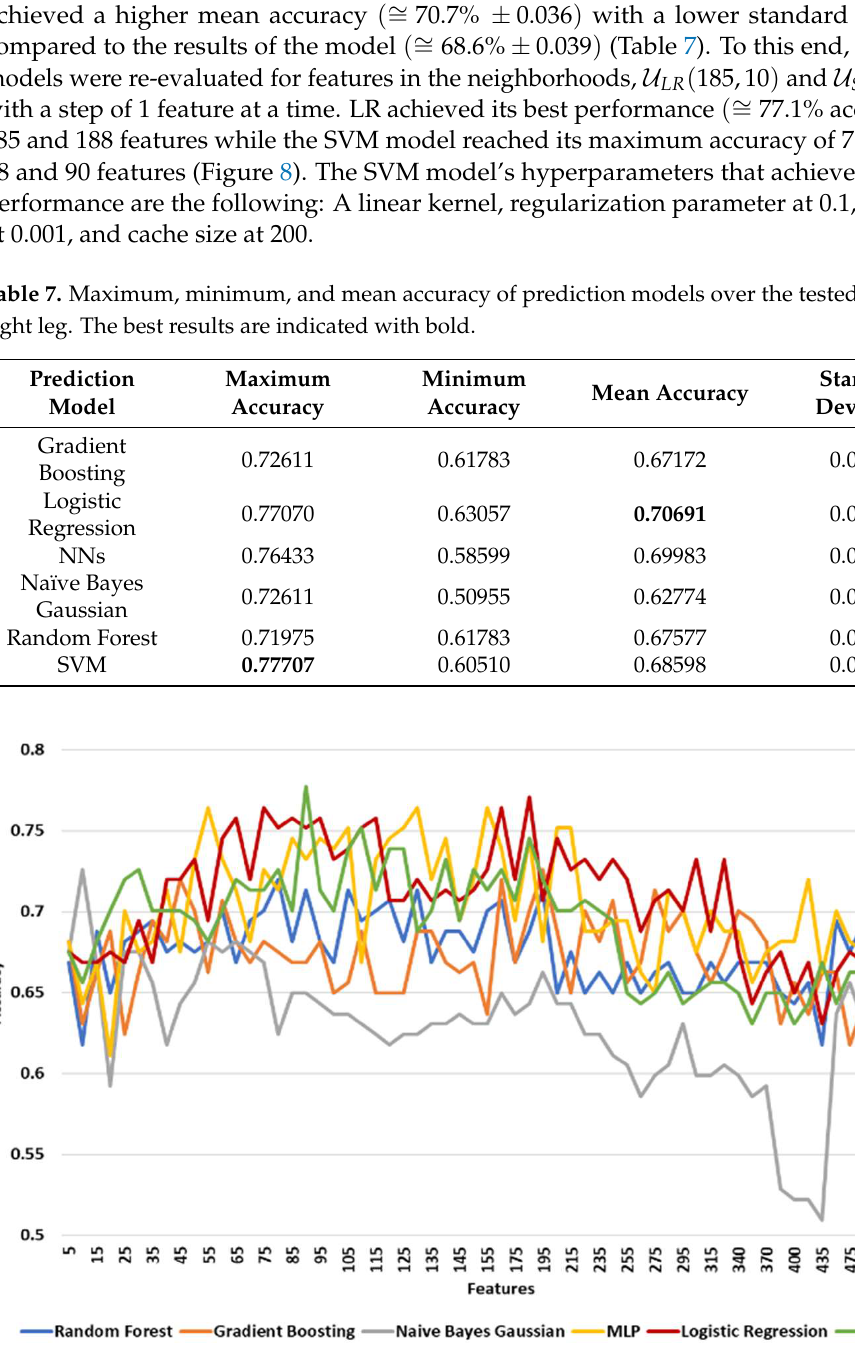
Figure 7. The accuracy of prediction models over test set for various number of features for the right leg. Results are shown with a step size of 5 (two features added at each step).